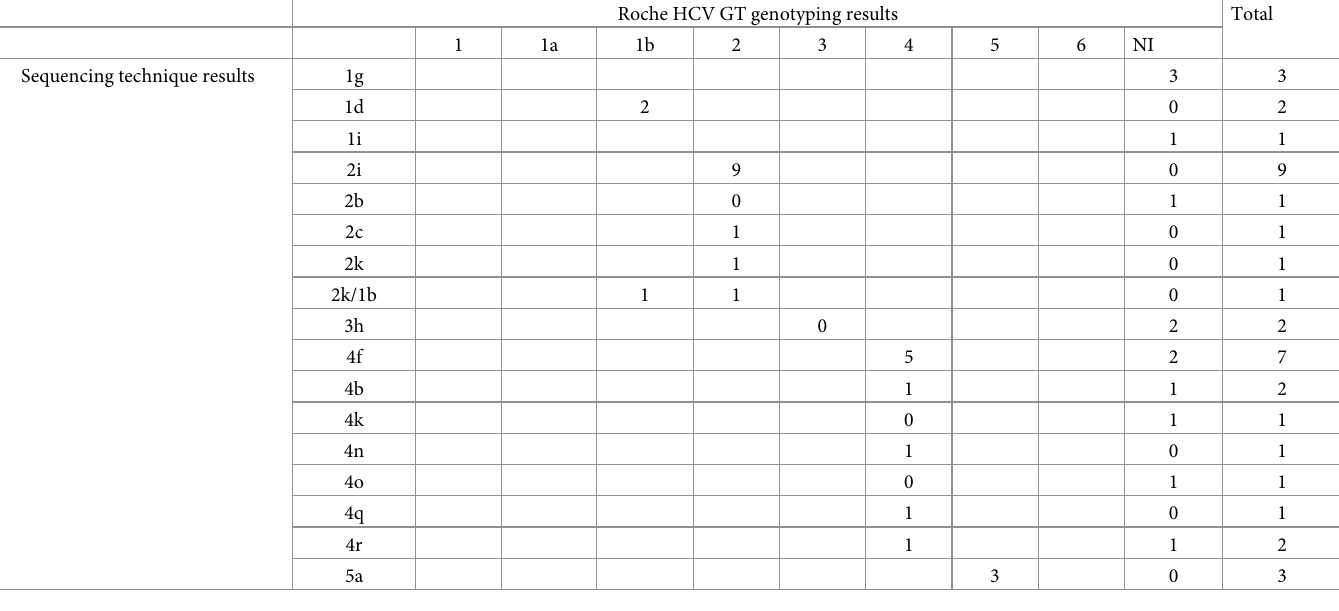
Table 3. Correspondence between results obtained with both techniques for the LiPA failed samples (n =